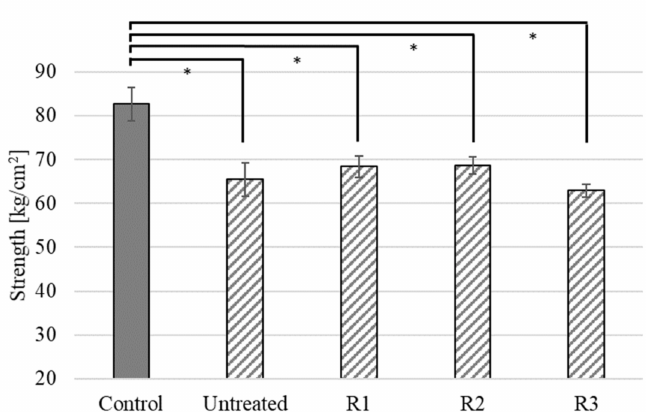
Figure 18. Flexural strength of mortars with addition of rubber at 5%, grain size T1, using cement C1, after 28 days. * ( p < 0.05).